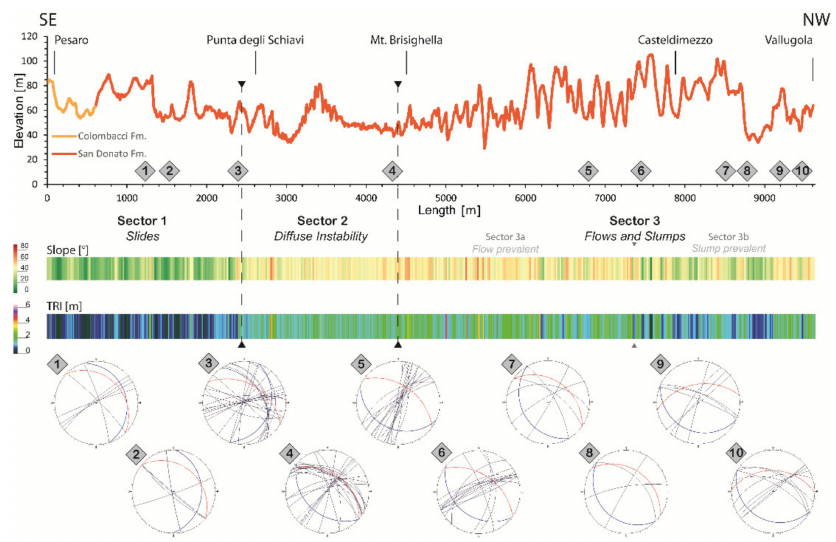
Figure 12. Altimetric profile along the coastline direction correlated with lithological information (the Colombacci Fm. in orange and the San Donato Fm. in red), slope value variation, TRI value variation, sector subdivision, indication of predominant landslide typologies occurring, and the stereographic projection in the lower hemisphere of the bedding attitude (continuous thick blue line), slope geometry (dashed red line), and main joint sets (thin dark